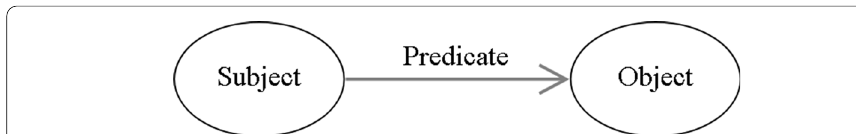
Fig. 11 Basic RDF triple comprising (subject, predicate, object)